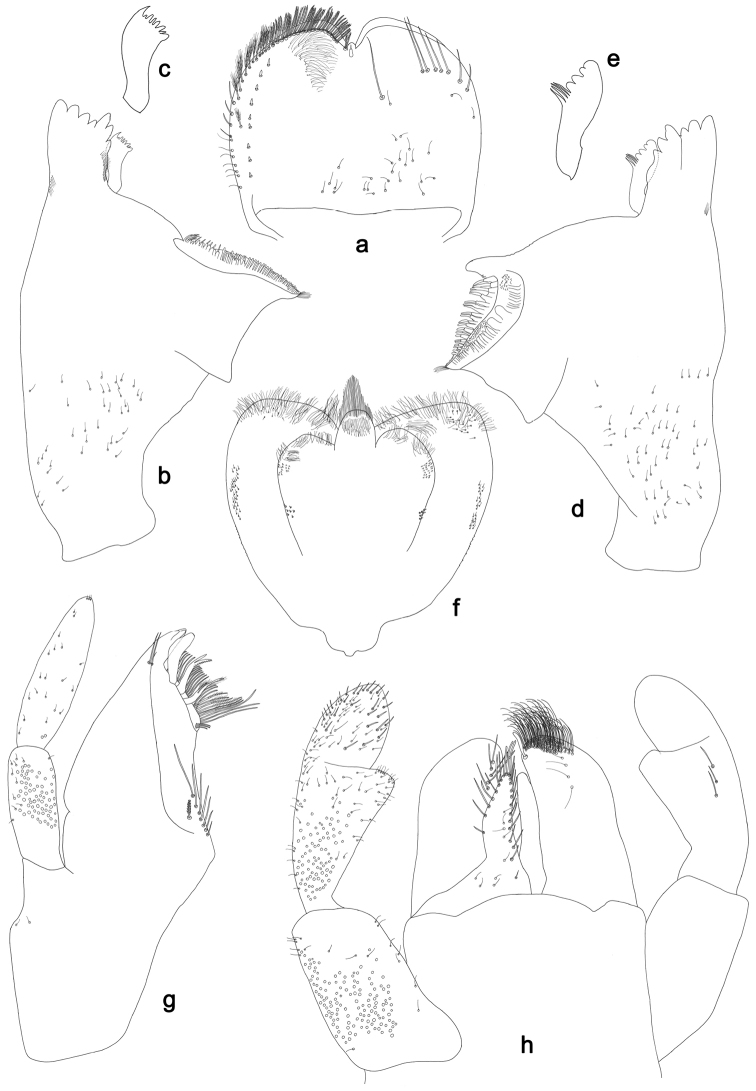
Labiobaetiswilhelmensis sp. n., larva morphology: a Labrum b Right mandible c Right prostheca d Left mandible e Left prostheca fHypopharynxg Maxilla h Labium.